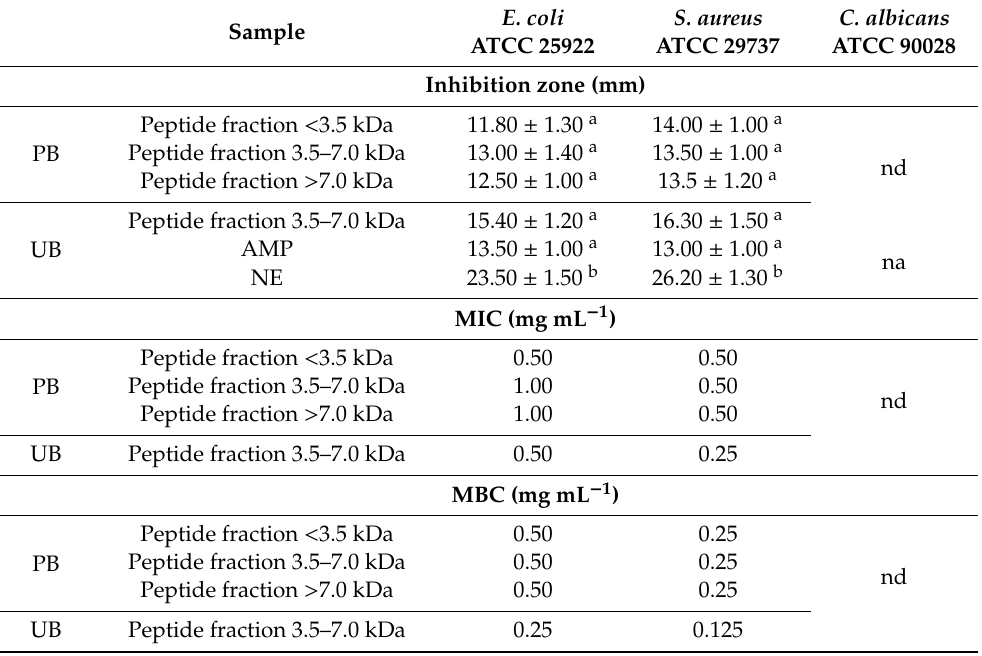
Table 5. Antimicrobial activity of peptide